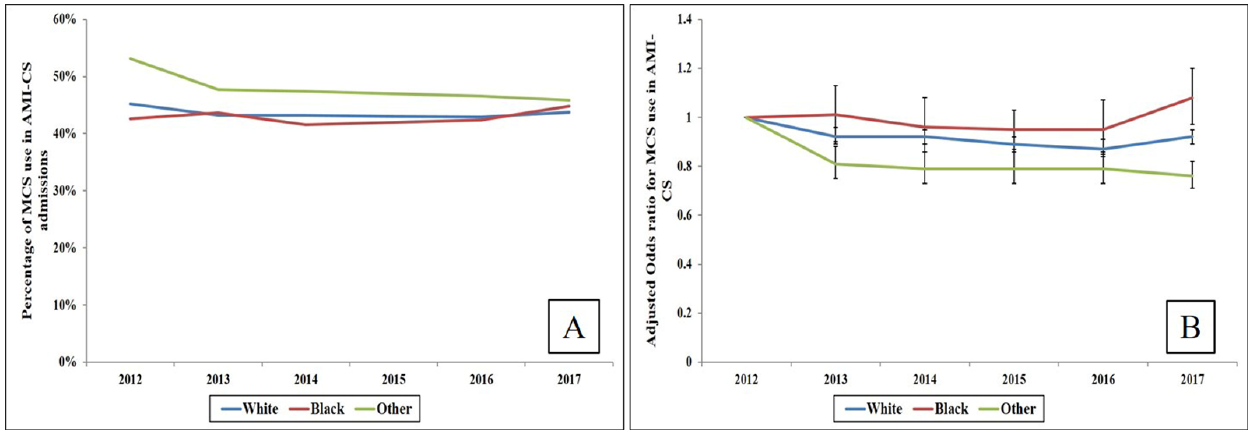
Figure 1. Trends in MCS use among race sub ‐ groups of AMI ‐ CS admissions. ( A ) Unadjusted trends in MCS use among racial sub ‐ groups of AMI ‐ CS ( p < 0.05 for temporal trend in white and other races); ( B ) Adjusted multivariable logistic regression for MCS use among race sub ‐ groups of AMI ‐ CS (referent year 2012); adjusted for age, sex, household income status, primary payer, comorbidity, and hospital characteristics ( p < 0.001 for temporal trend). Abbreviations: AMI: acute myocardial infarction; CS: cardiogenic shock; MCS: mechanical circulatory support Table 1. Baseline characteristics of race subgroups of AMI ‐ CS receiving MCS.